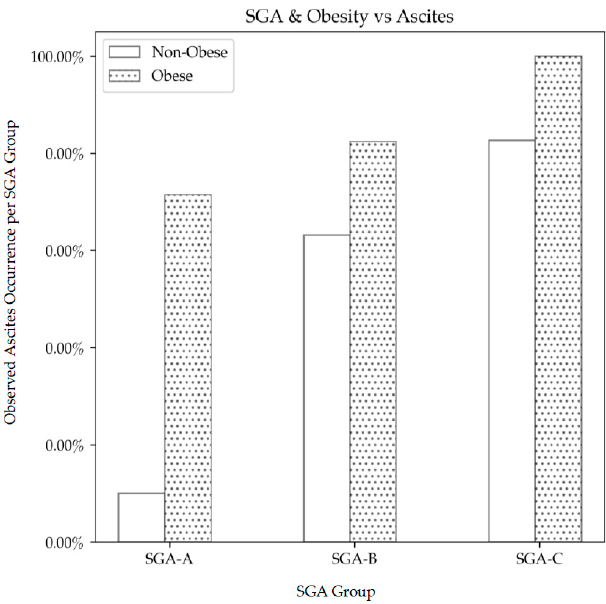
Figure 4. The distribution of ascites and obesity across SGA categories. There was a significant increase in ascites in obese well-nourished (SGA A) patients compared to non-obese well-nourished patients ( p = 0.007).